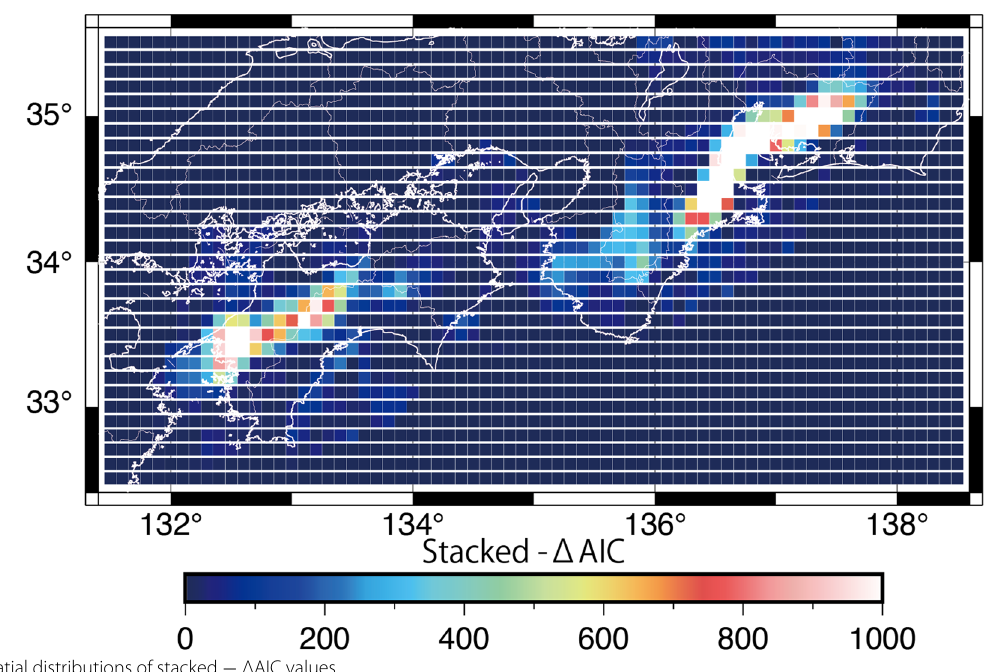
Fig. 5 Spatial distributions of stacked